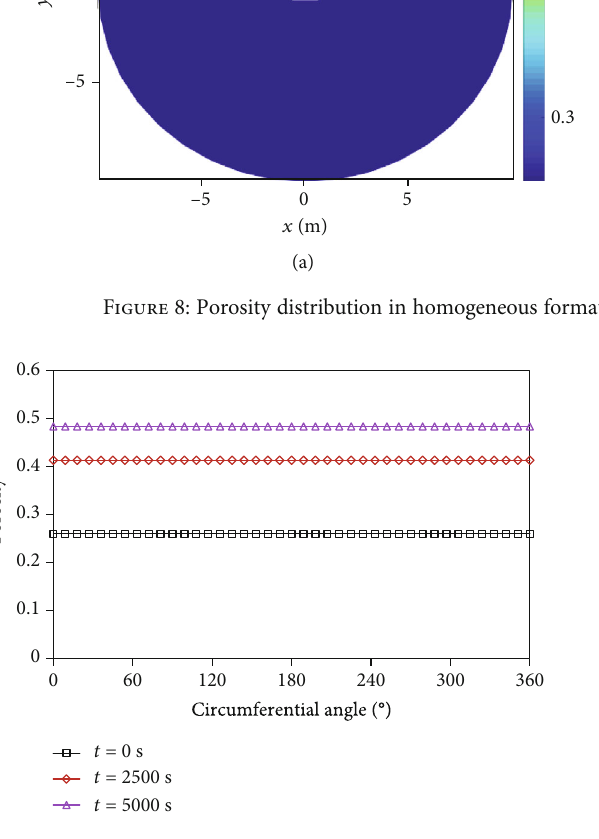
Figure 9: Porosity distribution surrounding the injection well at the borehole wall in homogeneous